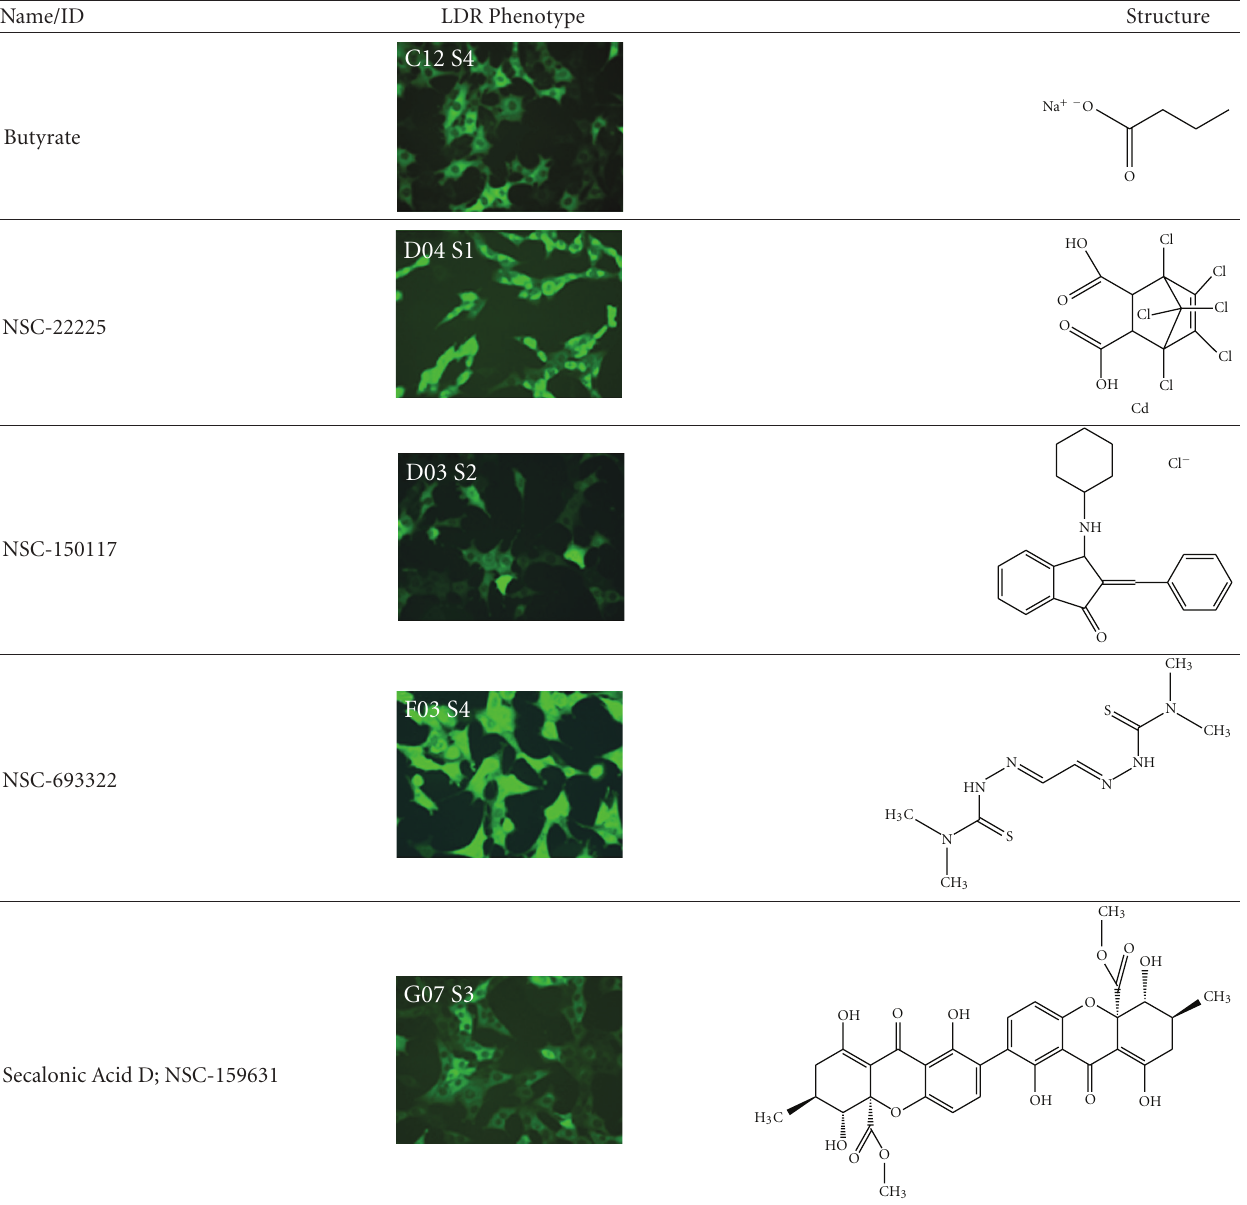
Table 1: Hits from the screen are diverse in their structure. Butyrate was used as a positive control. The nonautofluorescent hits caused cells to express GFP, but have unique